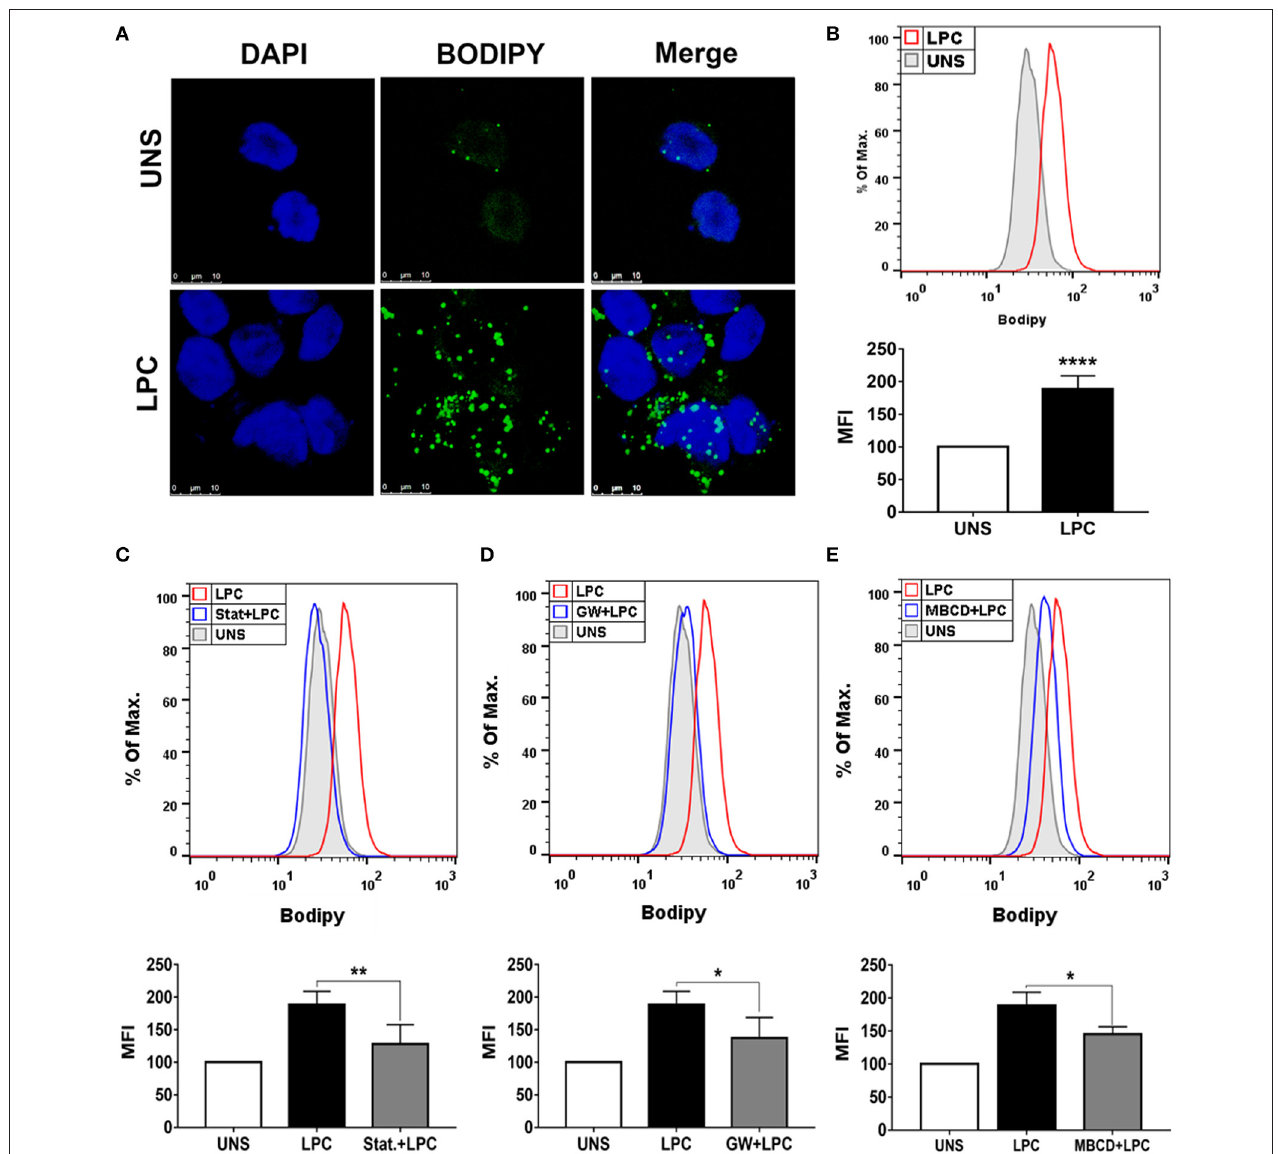
FIGURE 1 | Lysophosphatidylcholine (LPC) induces foam cell formation in human monocytes through mechanisms dependent on HMG-CoA reductase, PPAR- γ , and lipid rafts. (A) Human monocytes were stimulated with 1 µ g/ml of LPC, and after 24h, lipid droplets were stained with the fluorescent probe BODIPY (green), and the nucleus was labeled with DAPI (blue). Images were taken by confocal microscopy. Scale bar, 25 µ m. (B) Human monocytes were pretreated with (C) HMG-CoA reductase inhibitor (statin—Stat.), (D) antagonist of PPAR- γ [GW9662 (GW)], and (E) destabilizer of lipid rafts [methyl- β -cyclodextrin (MBCD)] for 1h and stimulated with 1 µ g/ml of LPC for 24h. Lipid droplets were stained with BODIPY and analyzed by flow cytometry. Histograms are representatives of three independent experiments. Each bar graphic represents the mean fluorescence intensity (MFI), and bars show significant differences and represent the 95% confidence interval (* p < 0.05, ** p < 0.01, and **** p < 0.0001) of the cells stimulated with LPC or UNS (unstimulated